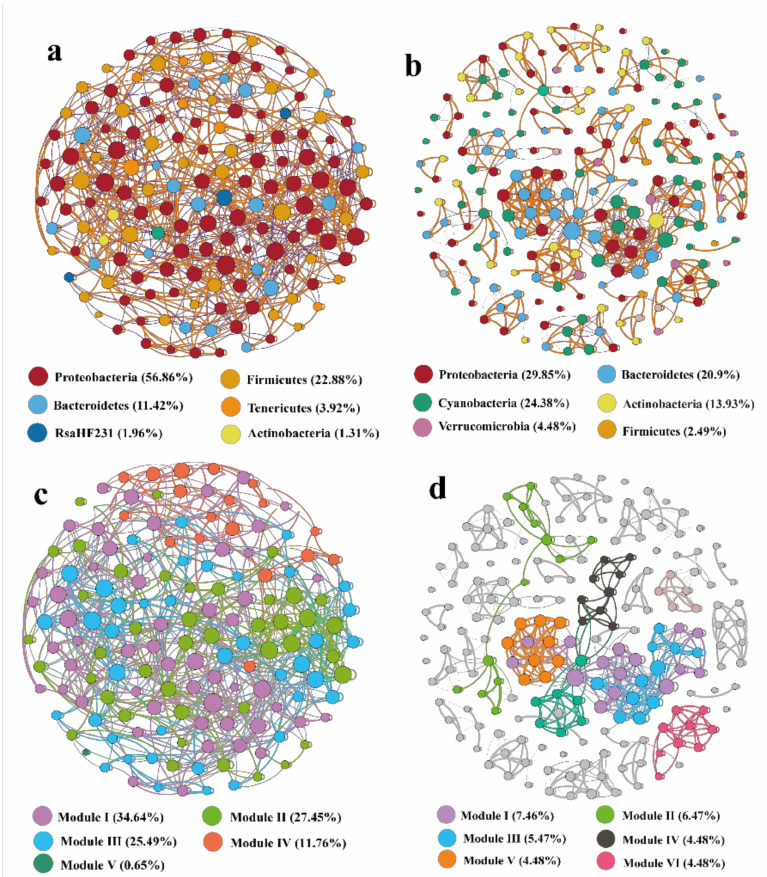
Figure 7. Spearman’s correlation-based network analysis of frequent ASVs (relative abundance > 0.05%) for ( a , c ) subsidence lakes and ( b , d ) river water samples. The size of each node is proportional to the number of connections (i.e., degree), and the nodes are colored according to different phyla. Orange and blue edges indicate positive and negative correlations,